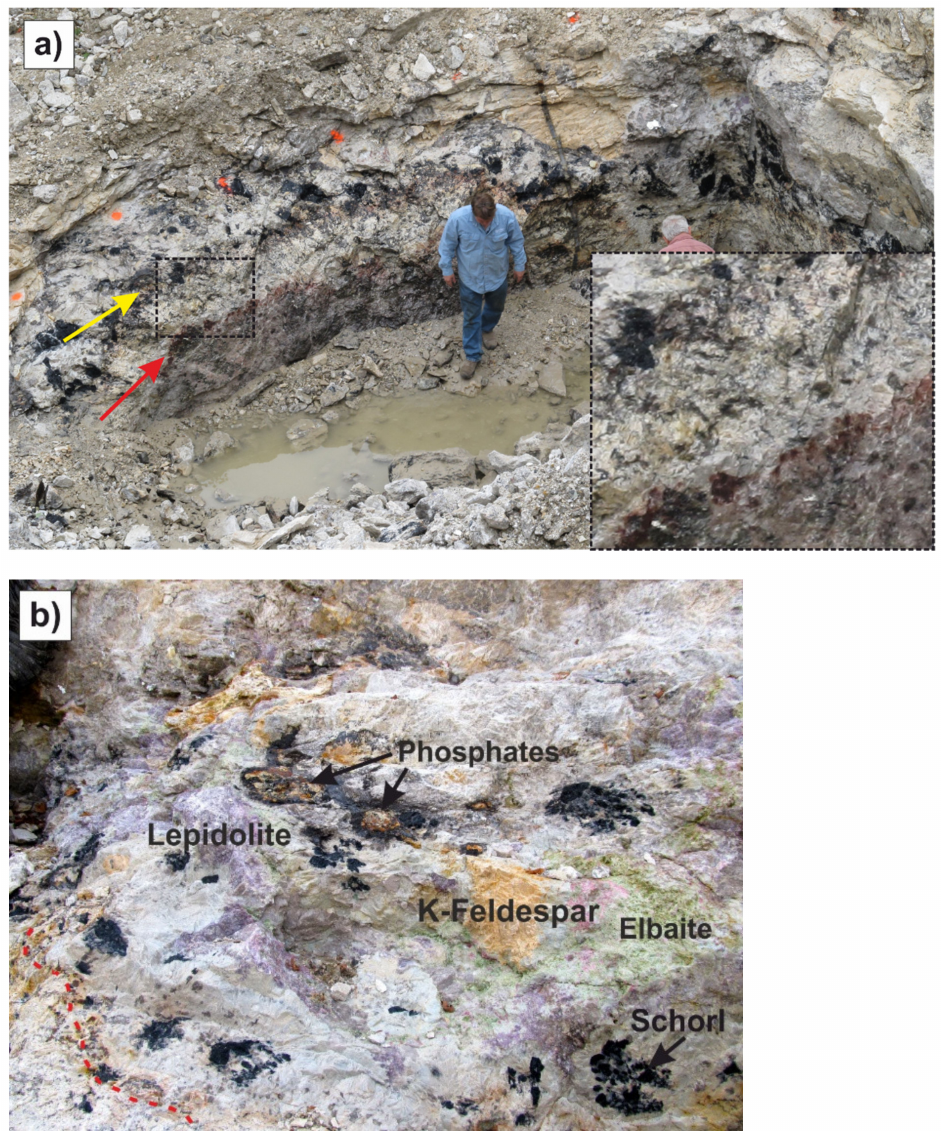
Figure 6. ( a ) General view of the Berry-Havey pegmatite. The red arrow points to the garnet layer, and the yellow arrow points to the tourmaline layer; ( b ) Lithium-rich pod from the core zone, hosted by the cleavelandite-rich core margin. The red dashed line in the left lower corner marks the garnet layer under the tourmaline